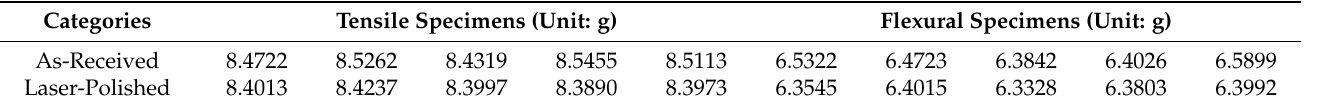
Table 4. Mass analysis of the